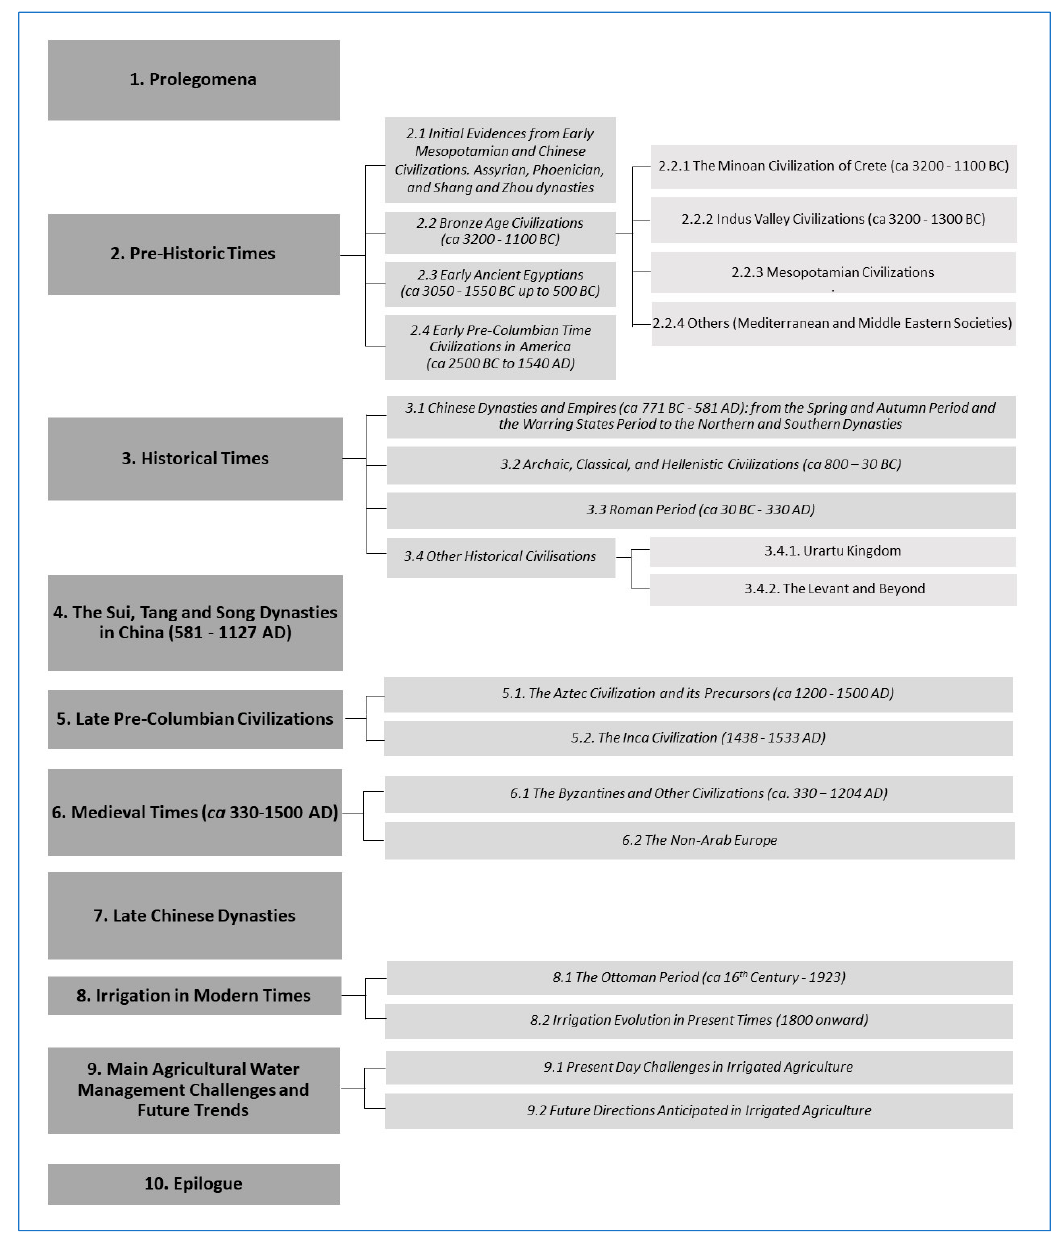
Figure 1. Structure of the present review paper.